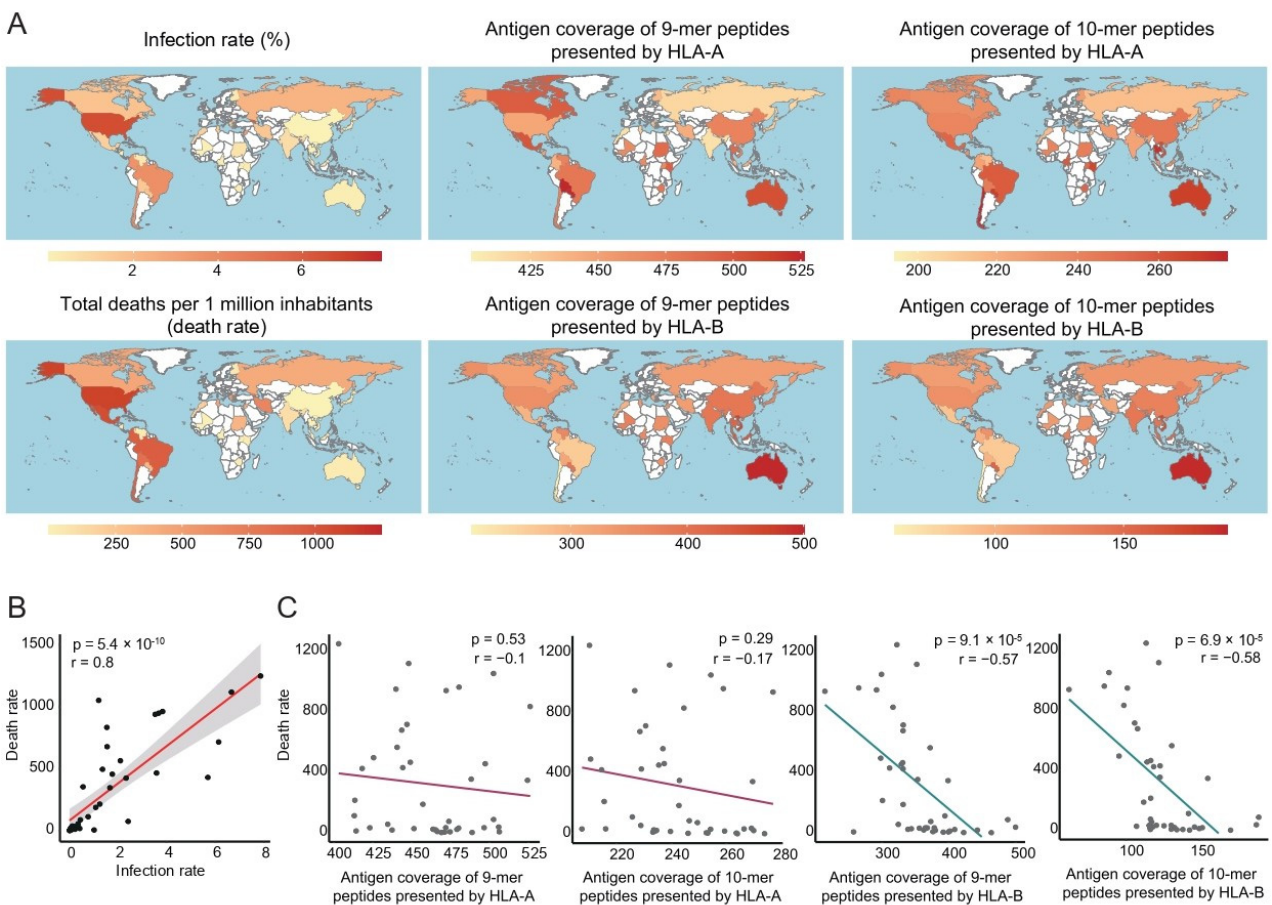
Figure 1. ( A ) Global heatmaps show antigen coverage of SARS-CoV-2, infection rate, and mortality of COVID-19 for each country. The antigen coverage in all figures is the result predicted by MHCflurry. ( B ) The results of linear regression of the COVID-19 infection rate and mortality for each country. The X -axis represents the infection rate, and the Y -axis represents the mortality rate. ( C ) The results of linear regression of antigen coverage and mortality. The X -axis represents antigen coverage, and the Y -axis represents mortality. The mortality rate was estimated as the number of total deaths per 1 million inhabitants. The red and blue lines indicate the correlation coefficient of mortality with the antigen coverage of HLA-A and HLA-B,